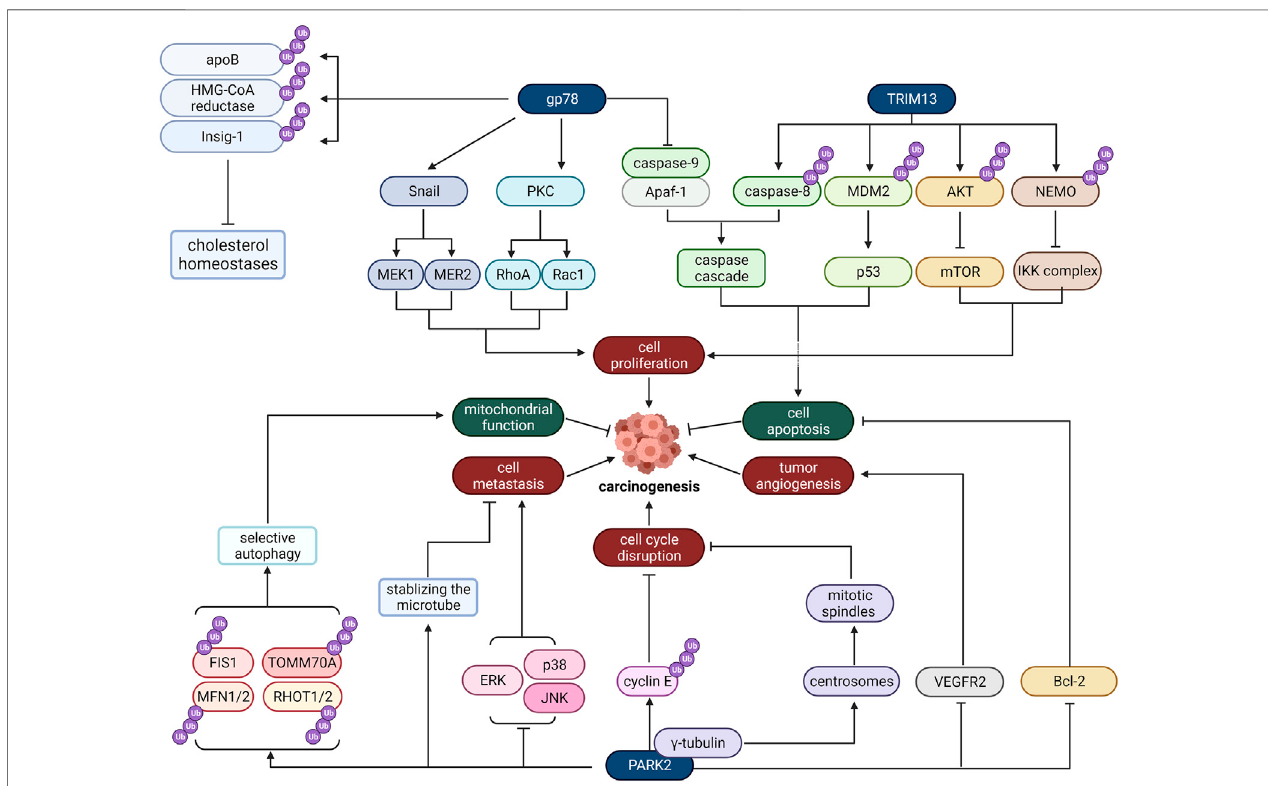
FIGURE 2 | The role of some typical ER-localized E3 ligases in cancer. Gp78, TRIM13, and PARK2 are ER-localized E3 ligases. They regulate carcinogenesis through many distinct pathways, involving cell proliferation, cell apoptosis, tumor angiogenesis, cell cycle disruption, cell metastasis and mitochondrial function.